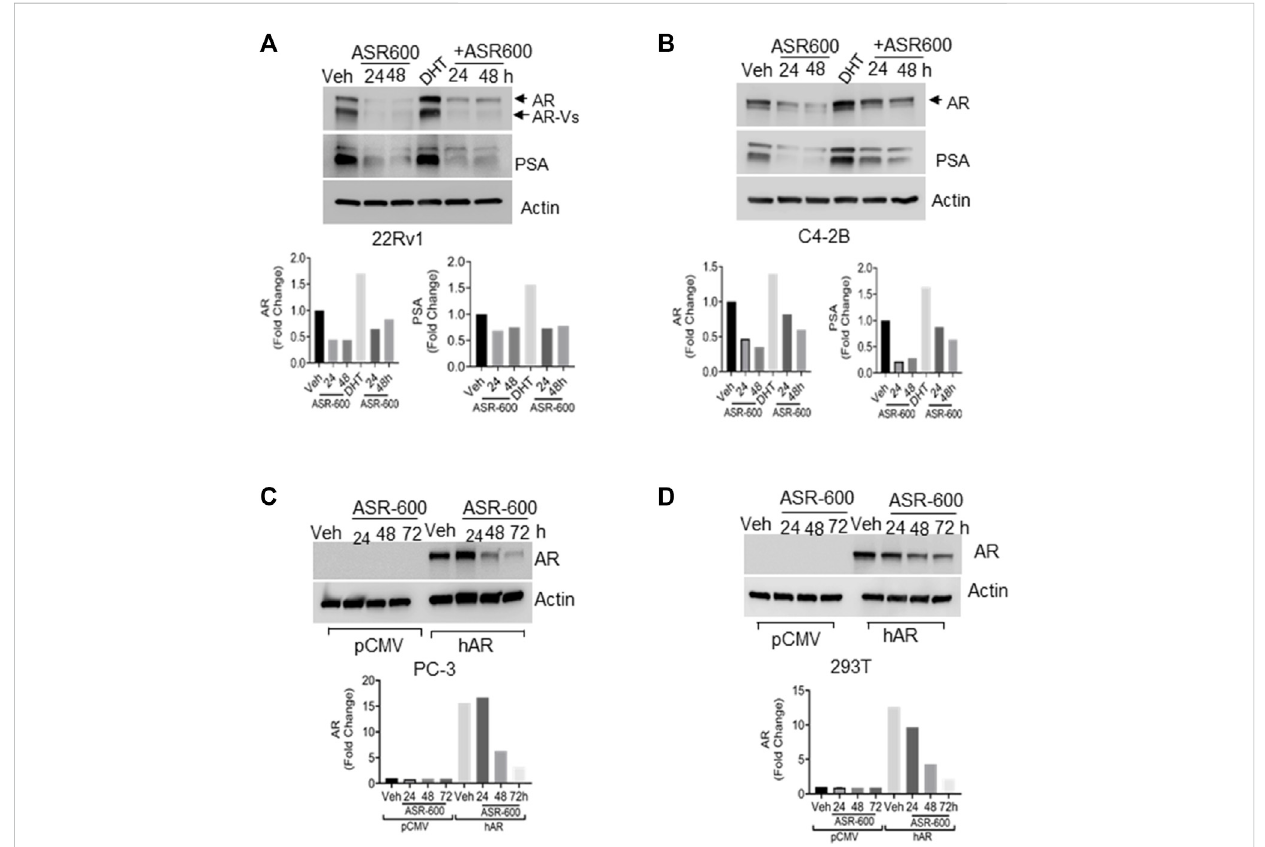
FIGURE 2 ASR-600inhibitsDHT-inducedAR/AR-V7expression. (A,B) .Immunoblots forAR,AR-V7andPSAexpressionsfollowingtreatedwithvehicle(DMSO) or ASR-600, DHT or DHT+ASR600 for 24 and 48 h in 22Rv1 and C4-2B cells. (C, D) Immunoblots for AR-expression in empty vector or AR transfected PC-3 or 293T cells following ASR-600 treatment for 24, 48, and 72